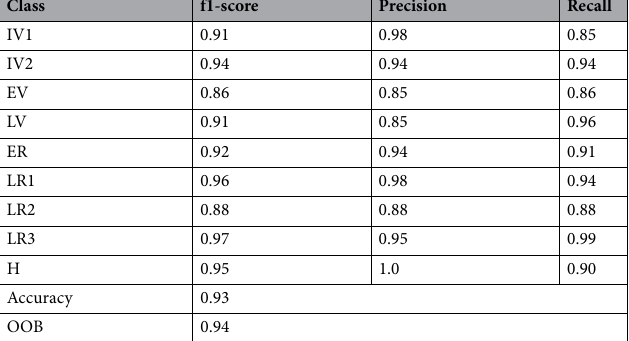
Table 2. Classification metrics when 2014, 2015, 2017, and 2018 years were used to train the model, and 2013 and 2016 as validation dataset. A total of 14,431 elements (corresponding to the phenological measurements for the years 2013 and 2016) were used for validation and a total of 26,088 elements (corresponding to the p phenological measurements for the years 2013, 2015, 2017 and 2018) were used for training.